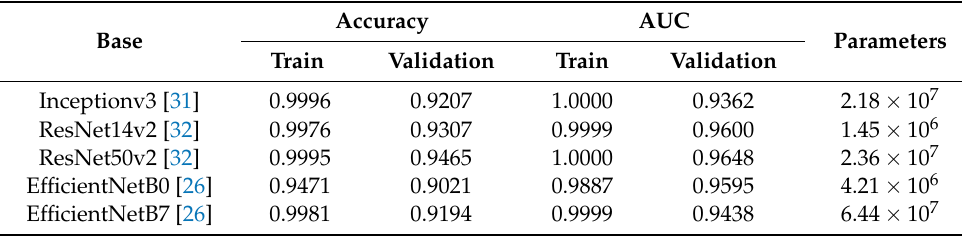
Table A1. Performance metrics for model alternatives during initial experimentation, along with number of parameters. Highly parameterized models exhibited